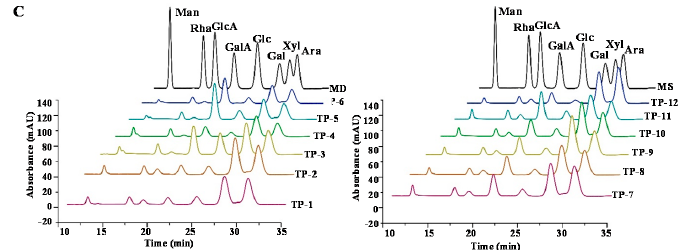
Figure 1. HPSEC chromatograms ( A ), FT-IR spectra ( B ), and HPLC profiles ( C ) of TPs. TPs 1–12 represent tea polysaccharides as shown in Table 1. Abbreviations: MS, mixed standards of monosaccharides; Man, Rha, GlcA, GalA, Glc, Gal, Xyl, and Ara indicate mannose, rhamnose, glucuronic acid, galacturonic acid, glucose, galactose, xylose, and arabinose, respectively.